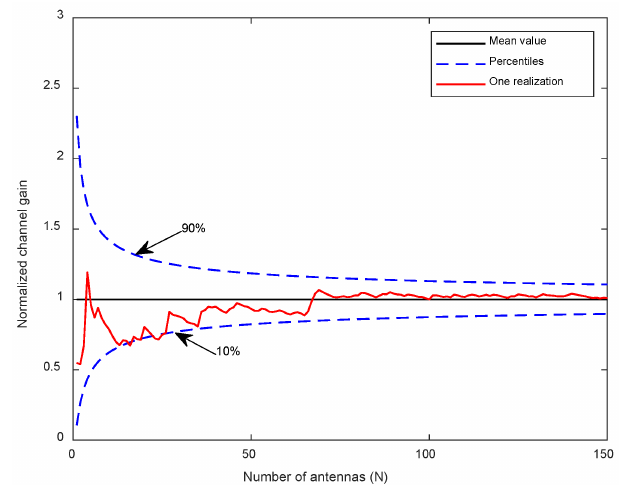
Figure 4. Comparison of channel hardening